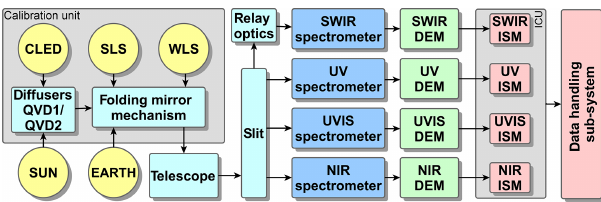
Figure 1. Schematic overview of the TROPOMI instrument. Shown are the different light paths from the Earth, Sun, and internal sources CLED, WLS, and SLS to the TROPOMI spectrometers. The detec- tor read-out is performed by DEMs, and the DEM control and data acquisition are performed by the